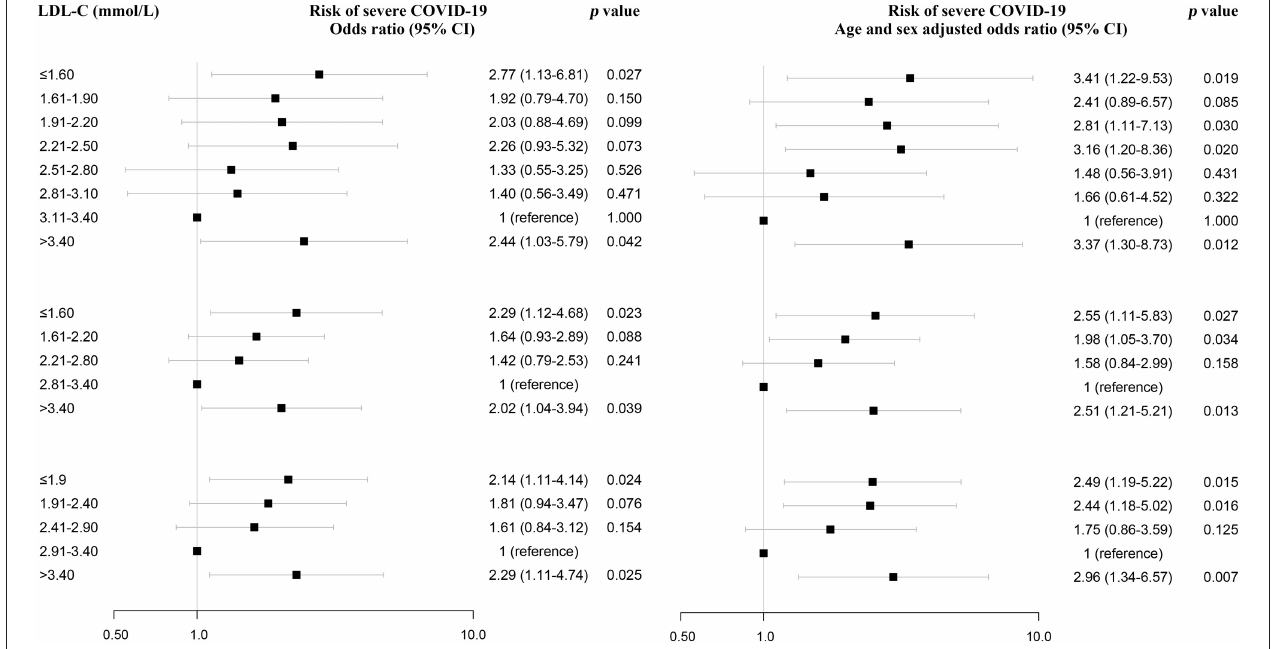
FIGURE 3 | Association between low and high serum LDL-C levels and severe COVID-19 from univariate logistic regression analysis. LDL-C and risk of severe COVID-19. Individuals are in the top part divided into 0.3 mmol/L (11.6 mg/dL) intervals, and in the bottom part into 0.6 mmol/L (23.2 mg/dL) and 0.5 mmol/L (19.3 mg/dL) intervals of LDL-C. The values of LDL-C with the lowest odds ratio were chosen as reference. Odds ratios were from univariate or multivariate logistic regression